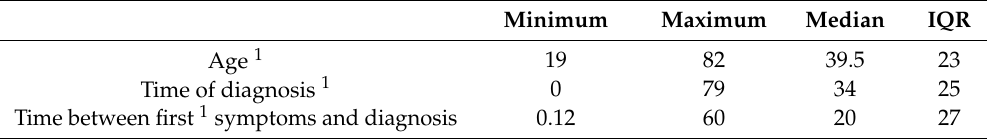
Table 2. Patient-specific information regarding age and diagnosis. IQR, interquartile range. Minimum Maximum Median IQR Age 1 19 82 39.5 23 Time of diagnosis 1 0 79 34 25 Time between first 1 symptoms and diagnosis 0.12 60 20 27 1 In years.